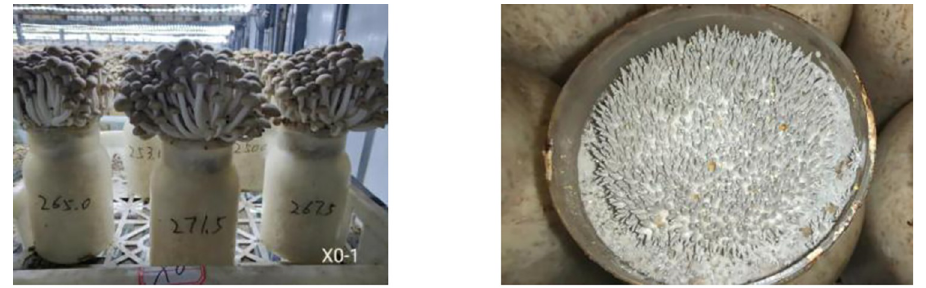
Fig 1. The fruiting body samples at bud stage and mature